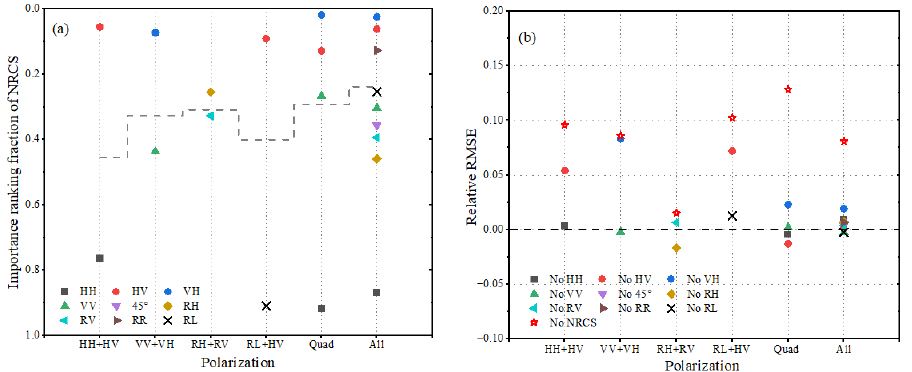
Figure 12. The importance of NRCS to SWH retrieval from combined-polarization models. ( a ) The importance ranking of NRCSs provided by XGBoost models, normalized to the range of 0 – 1. ( b ) The effect of removing NRCS on the SWH estimation from different polarized models. The red penta- grams represent the relative RMSE corresponding to the removal of NRCS-terms in the combined- polarization models.